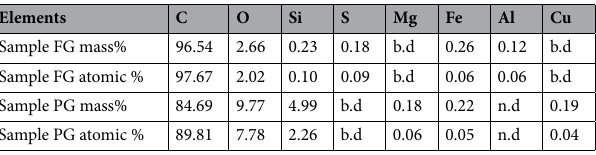
Table 1. Elemental analysis of graphite samples by EDS. b.d below the detection limits, n.d not detected.